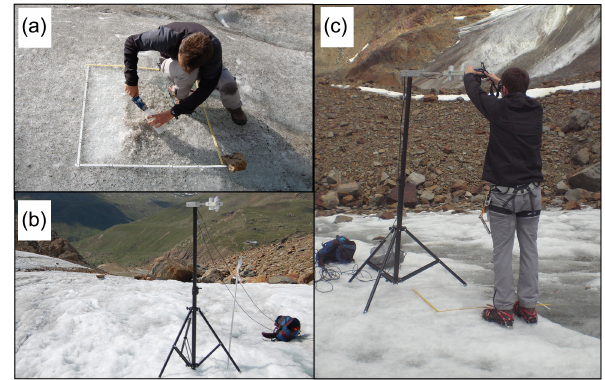
Figure 2. Series of pictures illustrating (a) sampling supraglacial debris, (b) measuring albedo and (c) acquiring high-resolution dig- ital images of the glacier